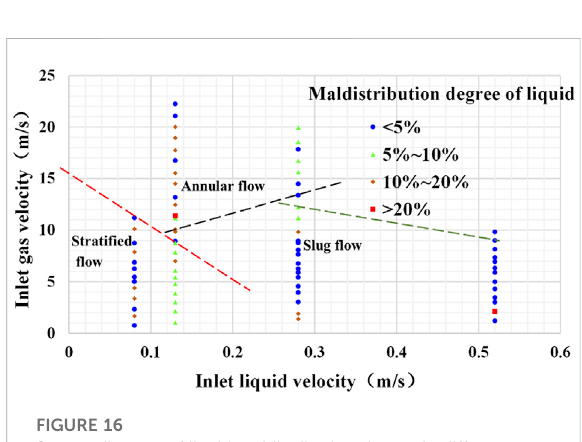
FIGURE 16 Scatter diagram of liquid maldistribution degree in different fl ow patterns in horizontal manifold without fl ute